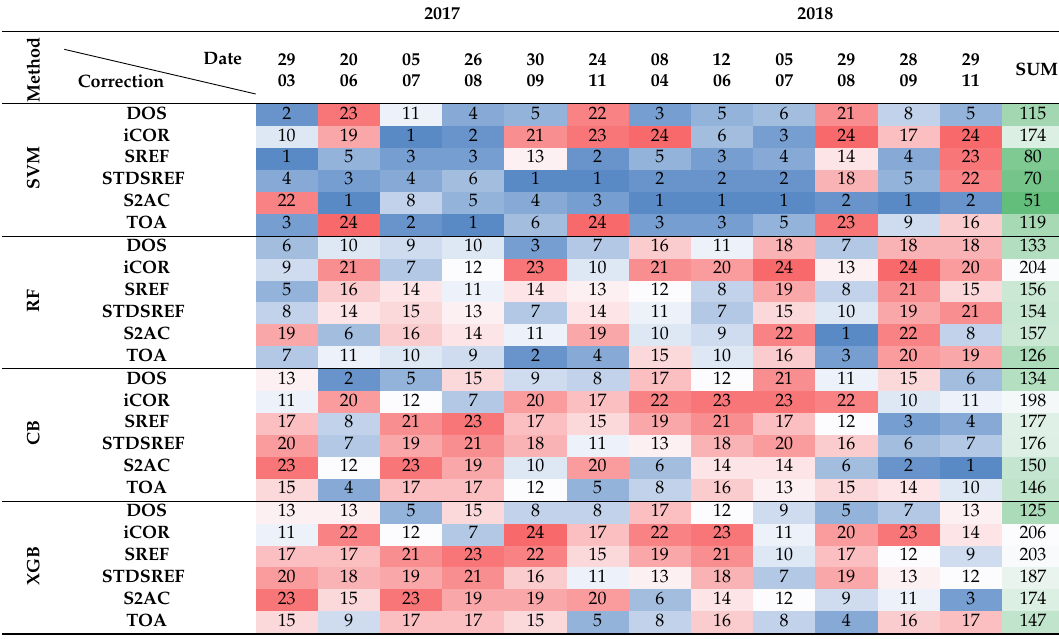
Table 3. Ranking of method and correction by date with included radiometric indices. Ranking is provided by place rank.